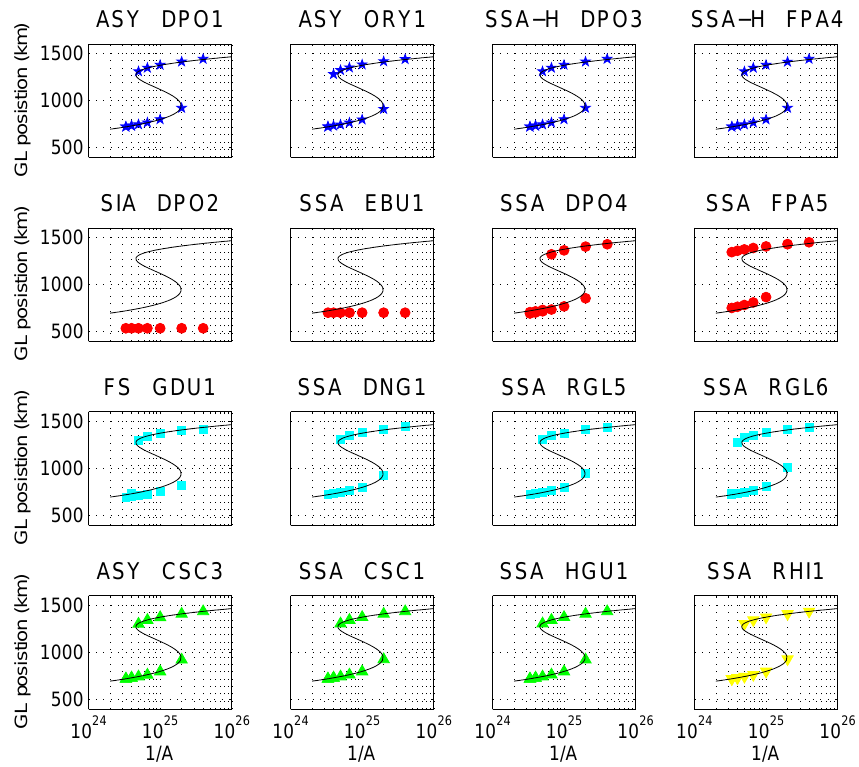
Fig. 5. Steady state grounding line positions as a function of ice viscosity ( A − 1 ) for EXP 3 (all models, only the “best” Mode for each of the models is retained). Colour coding and symbols according to the numerical implementation (see Fig. 3): MG (green triangles), AG (cyan squares), HPOMG (yellow inverted triangles), FG (red circles) and FGH (blue stars). The Schoof (2007a) solution is a black